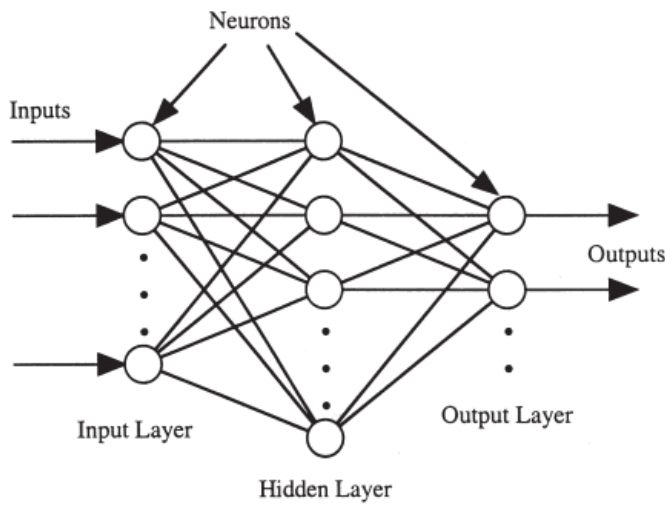
Figure 5. Image: [34] The structure of a feed-forward neural